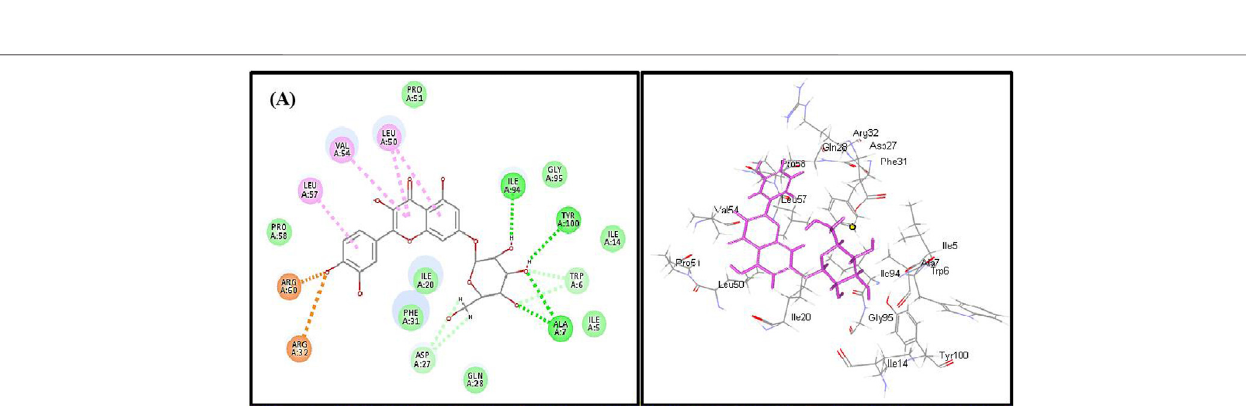
Frontiers in Pharmacology |